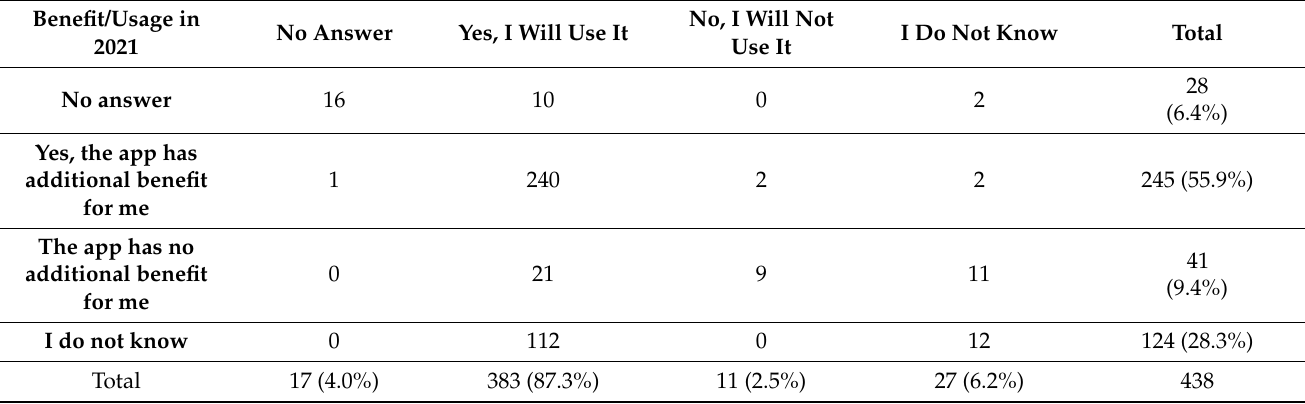
Table 7. Attitudes toward usage of the app in 2021 and additional benefits of the